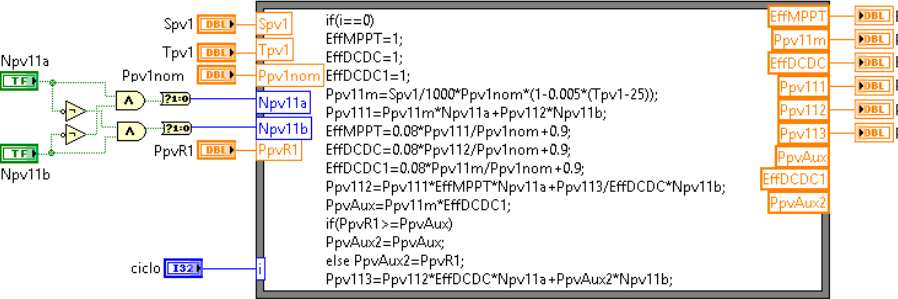
Figure 10. LabVIEW programming for PV generators.